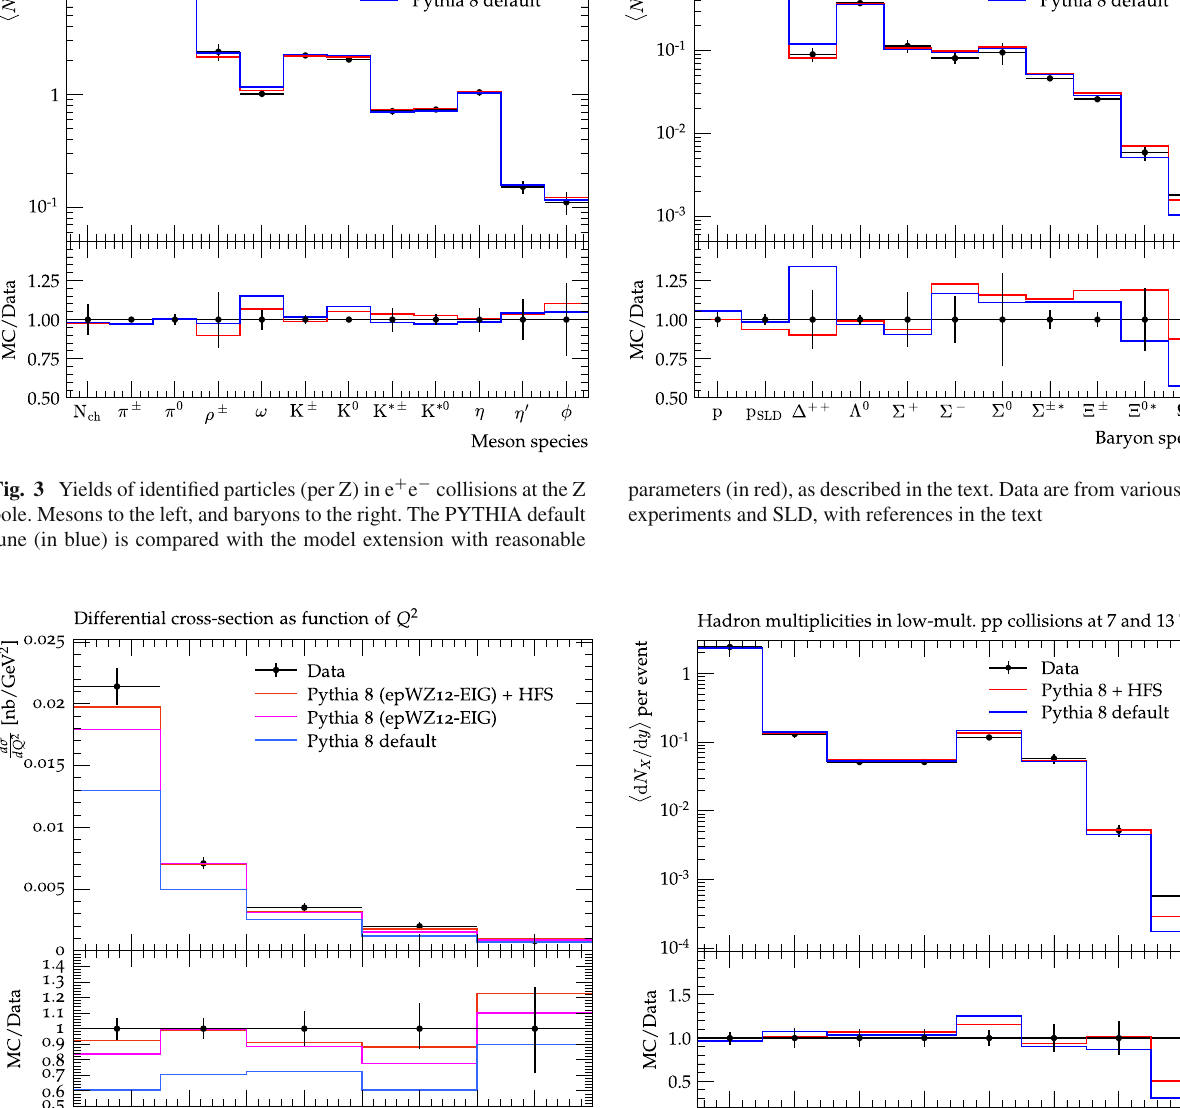
show hadron yields measured by ALICE in low multiplicity pp colli- sions at 7 TeV ( π ± , K 0 s , p, Λ 0 , Ξ ± and Ω − ) [1] and 13 TeV (K ∗ 0 and φ ) [46]. The data is again compared to PYTHIA default (blue) and with the HFS effects added